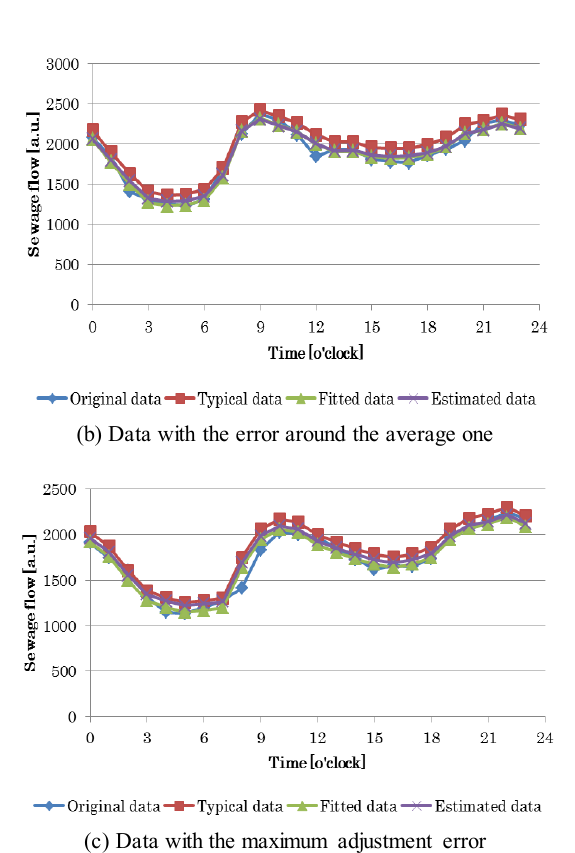
Fig. 5. Estimation of flow patterns considering day